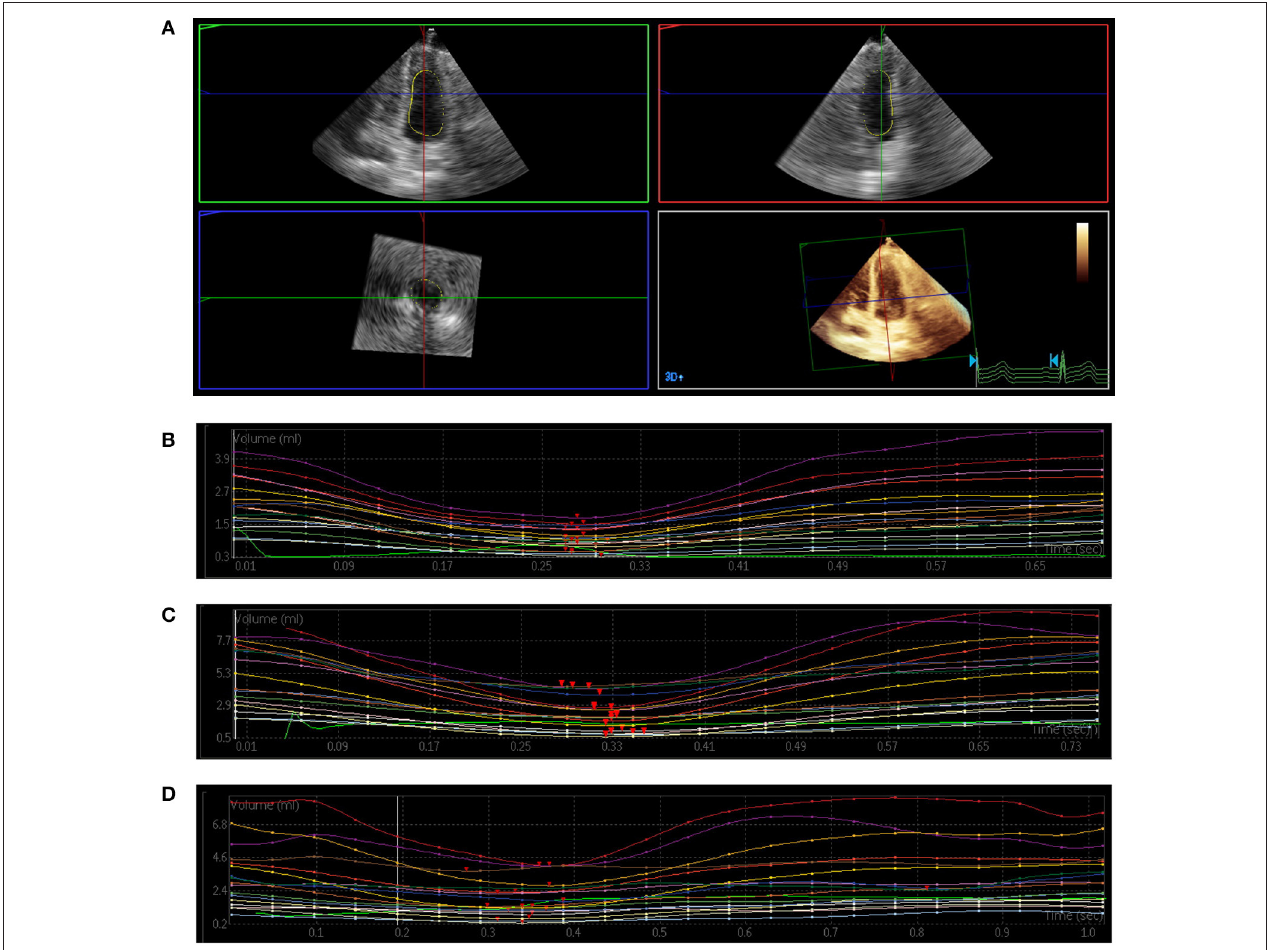
FIGURE 1 | Three-dimensional echocardiography assessment of left ventricular (LV) mechanical dyssynchrony. (A) Full-volume acquisition. (B) Patient with normal intraventricular synchrony. There is a regular time–volume curves, and the time of reaching the trough is consistent. (C) Patient with slightly intraventricular dyssynchrony. The time–volume curves is regular but not consistent. (D) Patient with severe intraventricular dyssynchrony. There is a disarray of the time–volume curves signifying LV